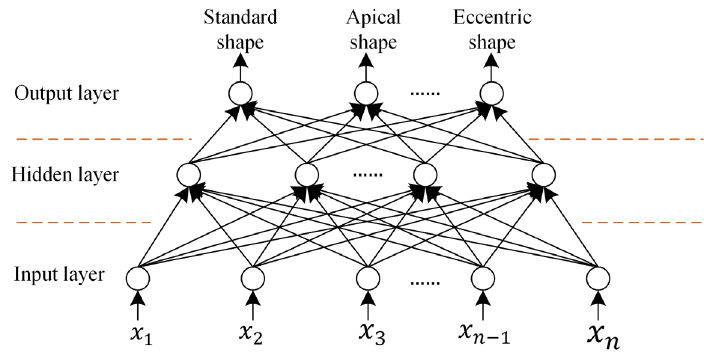
Figure 7. Pear shape BP neural network classifier. For the pear shape BP neural network classifier, the model structure is shown in Figure 7. The algorithm steps are as follows.